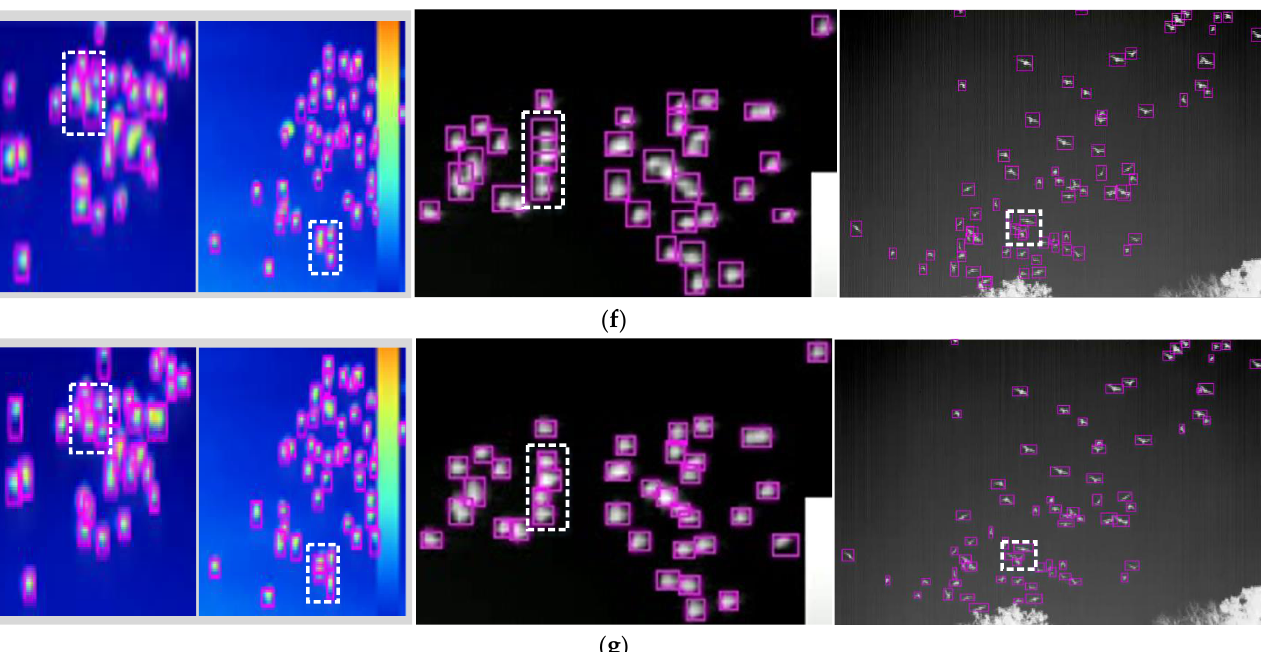
Figure 7. Subjective detection results of several methods, ( a ) original image; ( b ) enlarged version of the selected region; ( c ) the detection results of Mask-RCNN [14]; ( d ) the detection results of DRU- Net [16]; ( e ) the detection results of DNA-Net [32]; ( f ) the detection results of Yolov4 [12]; ( g ) the detection results of our method. Table 4. Frame rate comparison